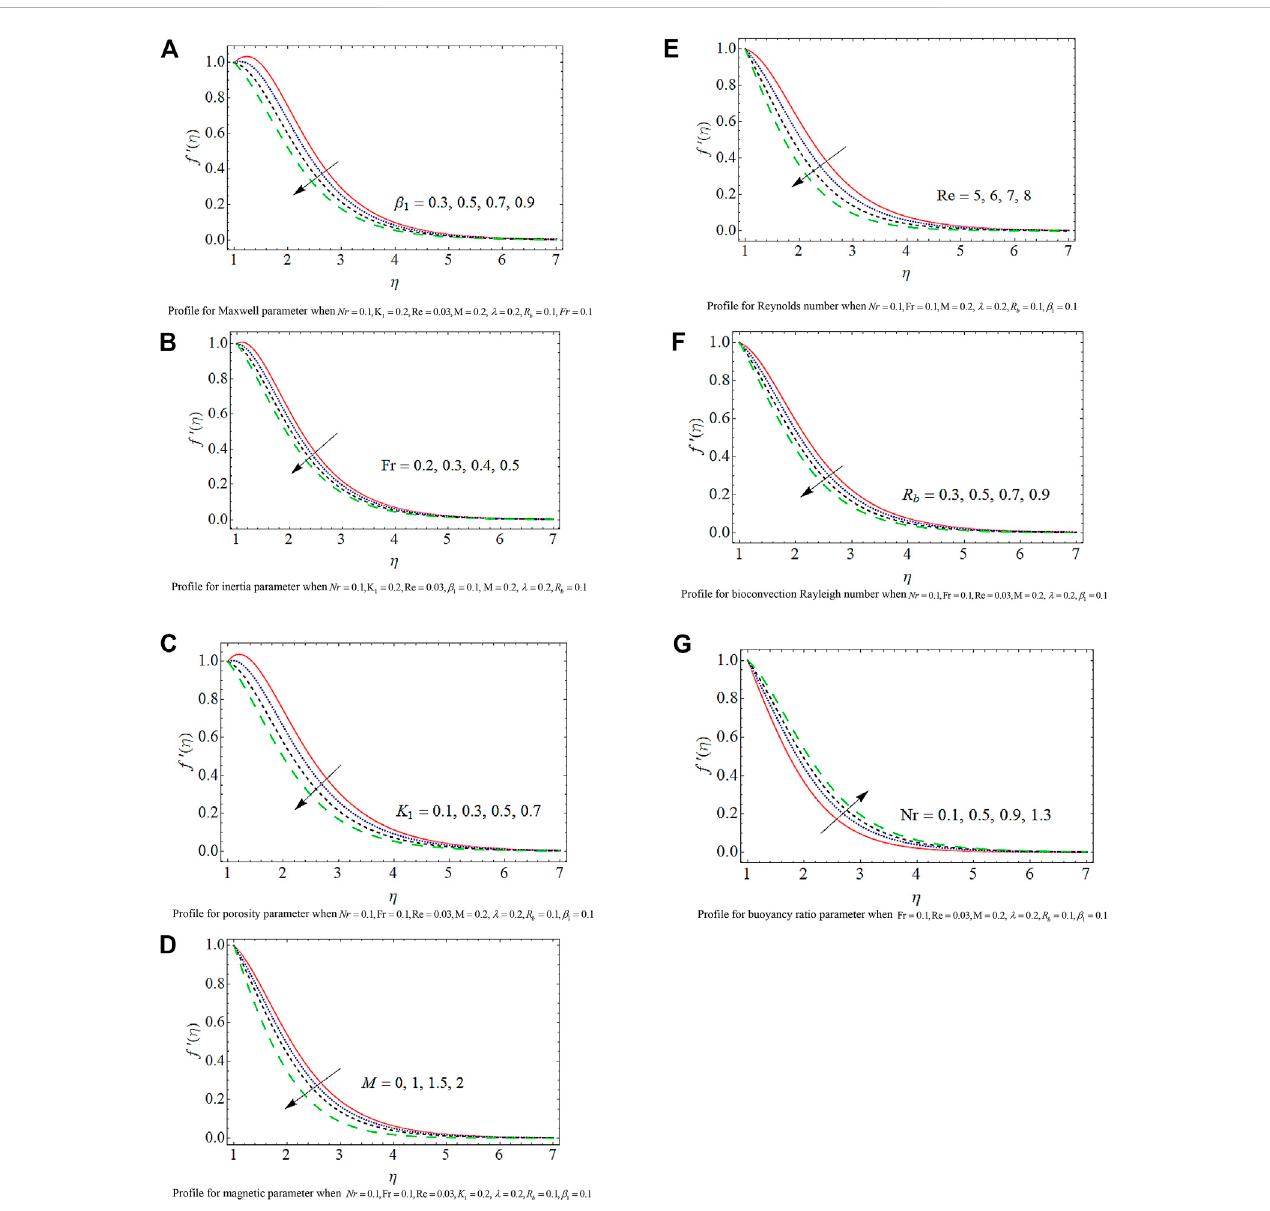
FIGURE 2 Flow pro fi les under the impact of various substantial